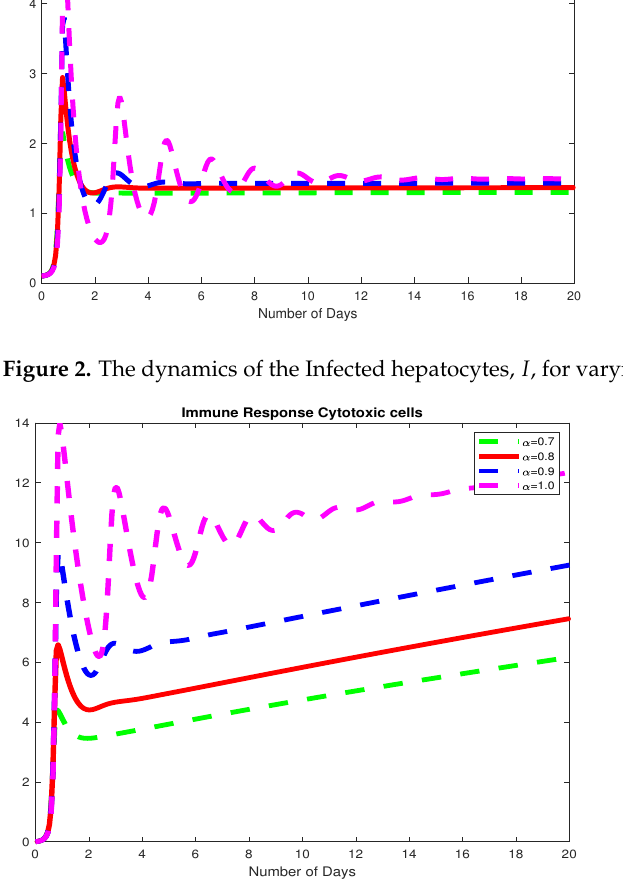
Figure 3. The dynamics of the immune response cytotoxic cells, R , for varying fractional order α